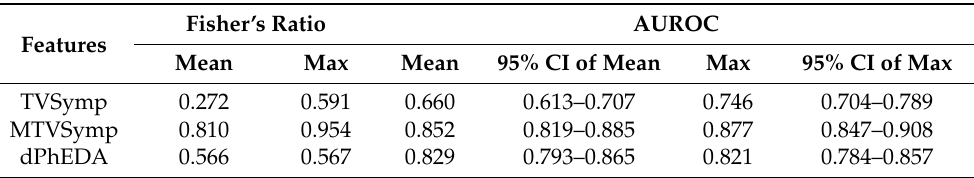
Table 2. Statistical analysis on difference between painless and pain segments for both EP and TG datasets.